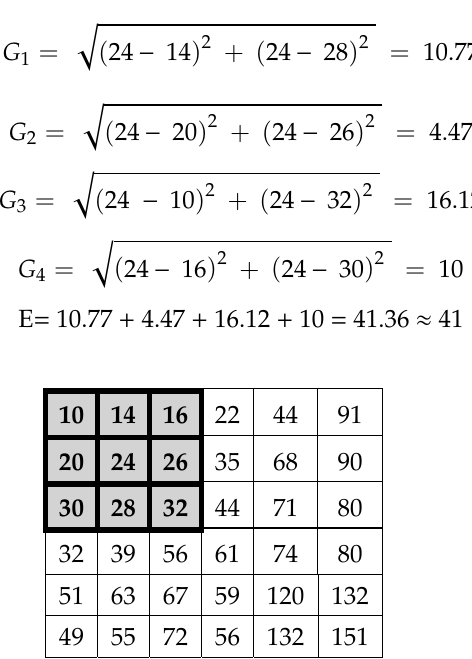
9 of 23 Figure 5. Integration of the image gradients by using GT2 FSI + MG.